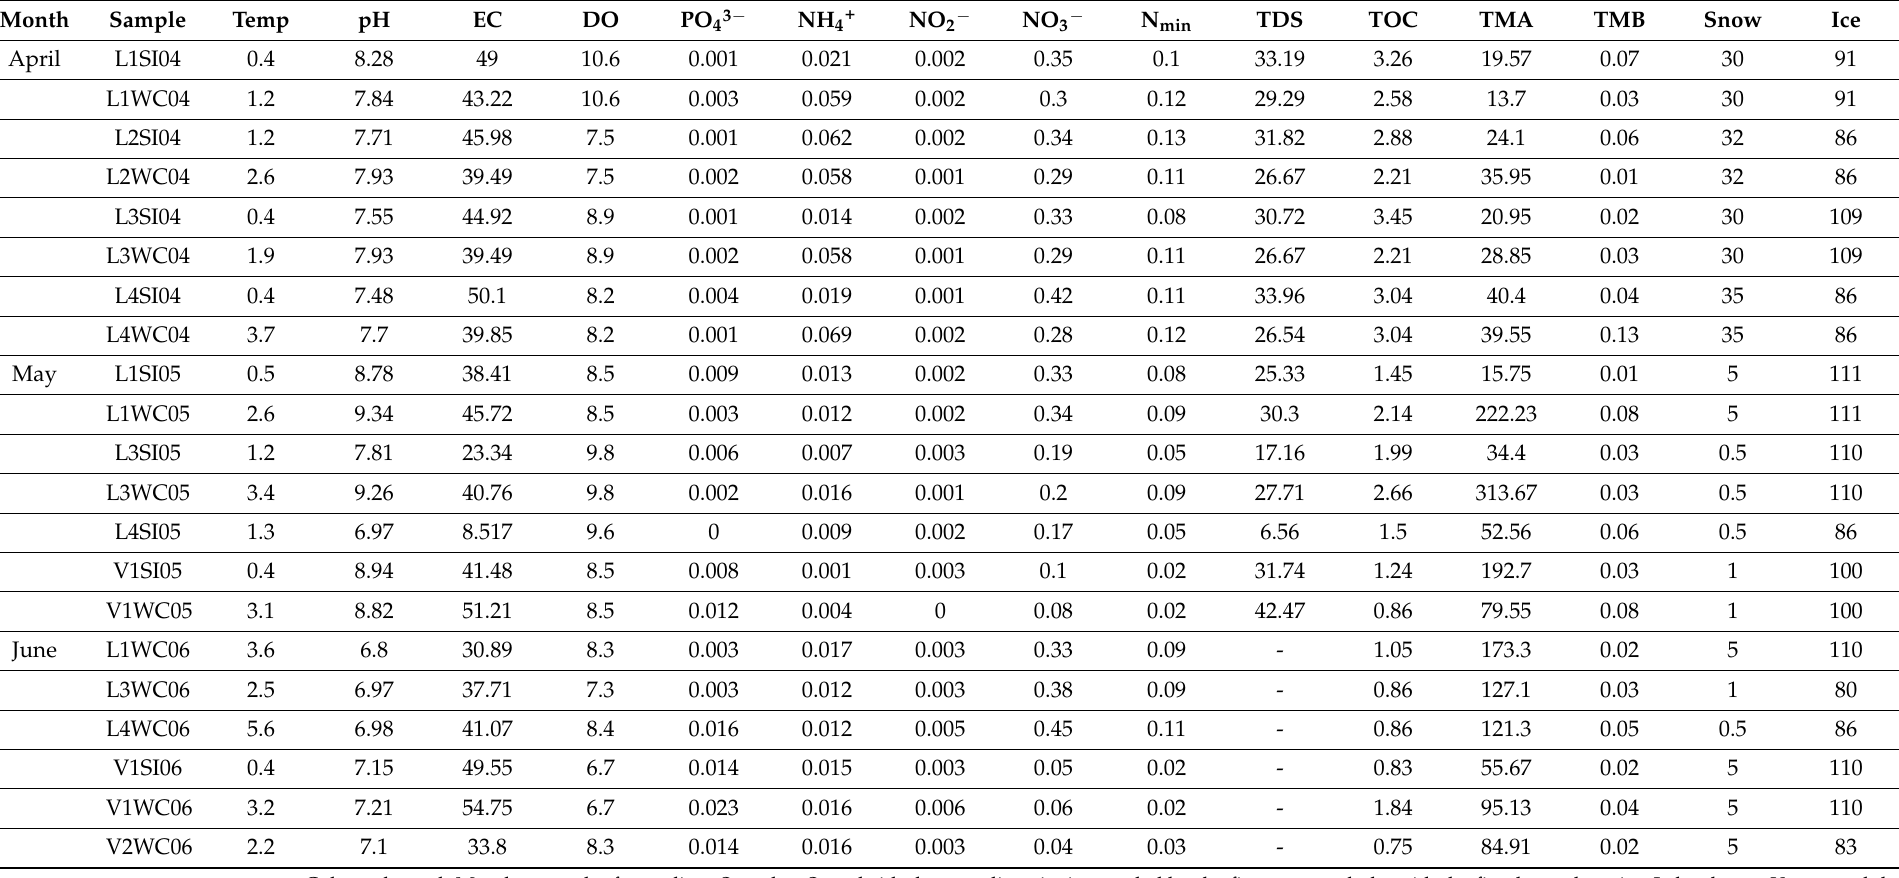
Table 1. Hydrophysical and hydrochemical characteristics of